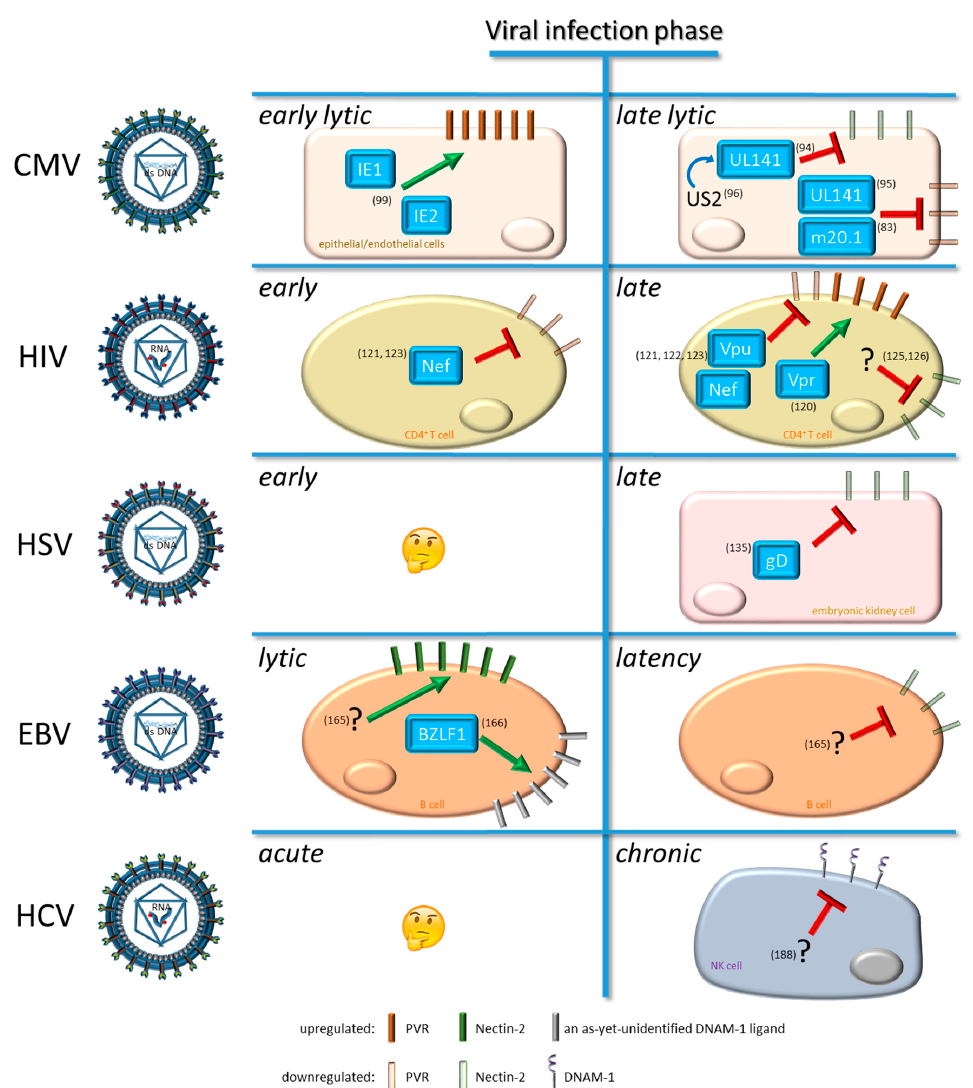
Figure 2 . Viruses differently modulate the expression of DNAM-1 and their ligands depending on the infection phase. The viruses mentioned in this review (CMV, HIV-1, HSV, EBV, and HCV) differently express proteins associated with the various viral infection phases. Viral proteins (blue boxes) can upregulate (green arrow) or downregulate (red inhibition symbol) the expression of DNAM-1 and its ligands, such as PVR and Nectin-2, as reported in the legend. The US2 protein of CMV supports the immunomodulating function of UL141 during viral infection (blue arrow). References relative to each mechanism are reported in parenthesis. General missing information are indicated by emoticons, while missing information on viral molecules are indicated by question marks.